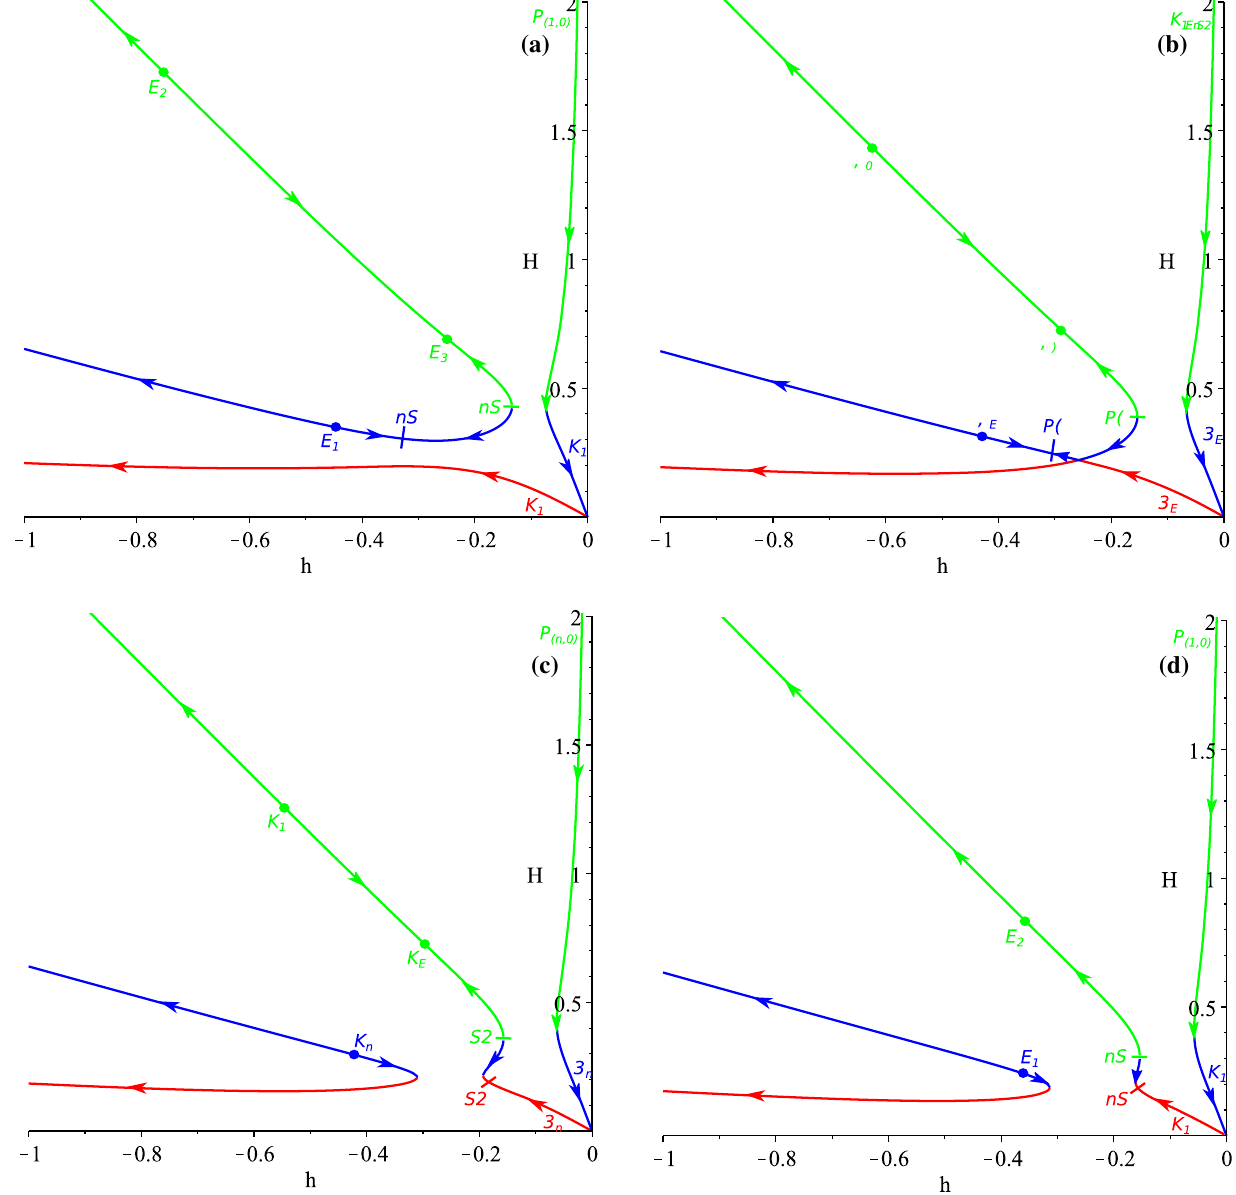
Fig. 5 Additional regimes which emerge in D = 7 vacuum cubic Lovelock case, on H ( h ) evolution curves; different colors correspond to three different branches H 1 , H 2 and H 3 ; panels layout is as follows: μ 3 > μ > μ 2 on a , μ = μ 3 on b , μ 4 > μ > μ 3 on c and μ = μ 4 on d (see the text for more